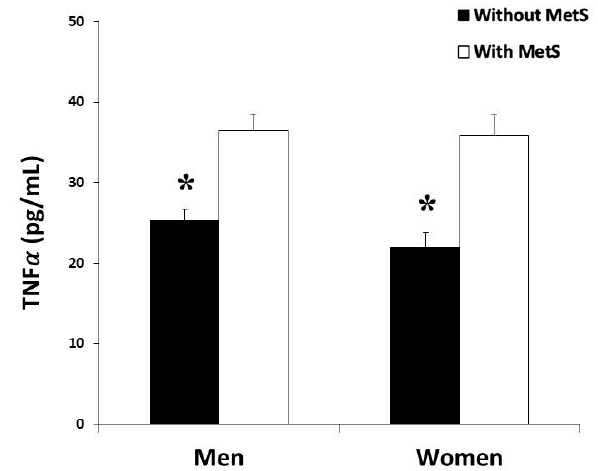
Figure 2. Tumor necrosis factor α (TNF α ) production rate in plasma men and women in the study, classified according to the metabolic syndrome. Results are presented as mean ± SEM. Significant effects of metabolic syndrome were found in both groups by two-way ANOVA. *Differences in means between participants without and with MetS.